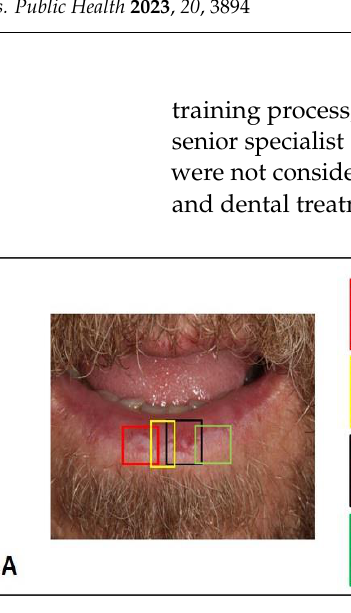
Figure 4. Image crop strategies for network training. ( A ) Images with multiple lesions: each lesion was delimited and cropped separately. ( B ) Demonstrates strategy for including lesion boundaries in the training set.